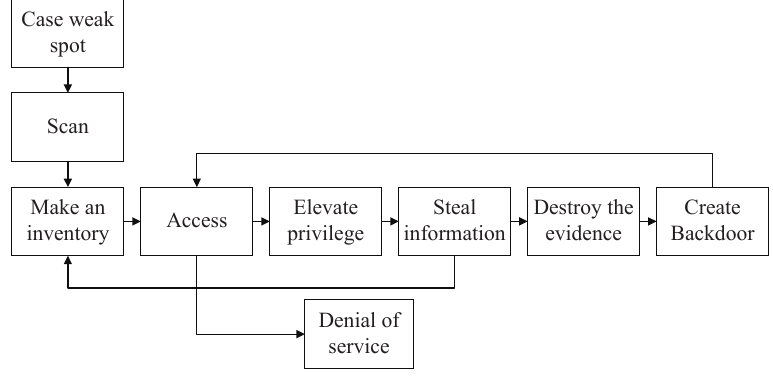
Figure 1. Network attack